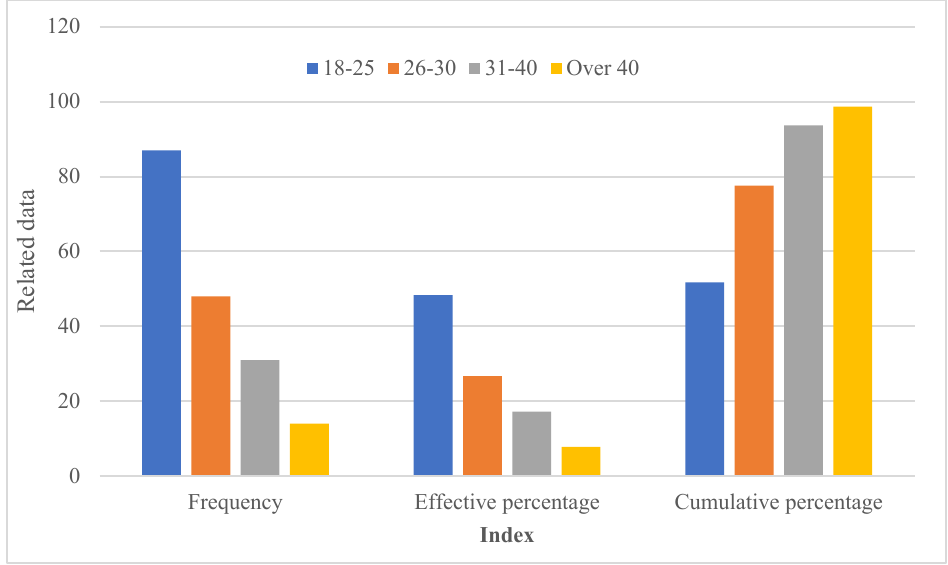
Figure 7. User age statistics. Table 2. Usage of the user payment